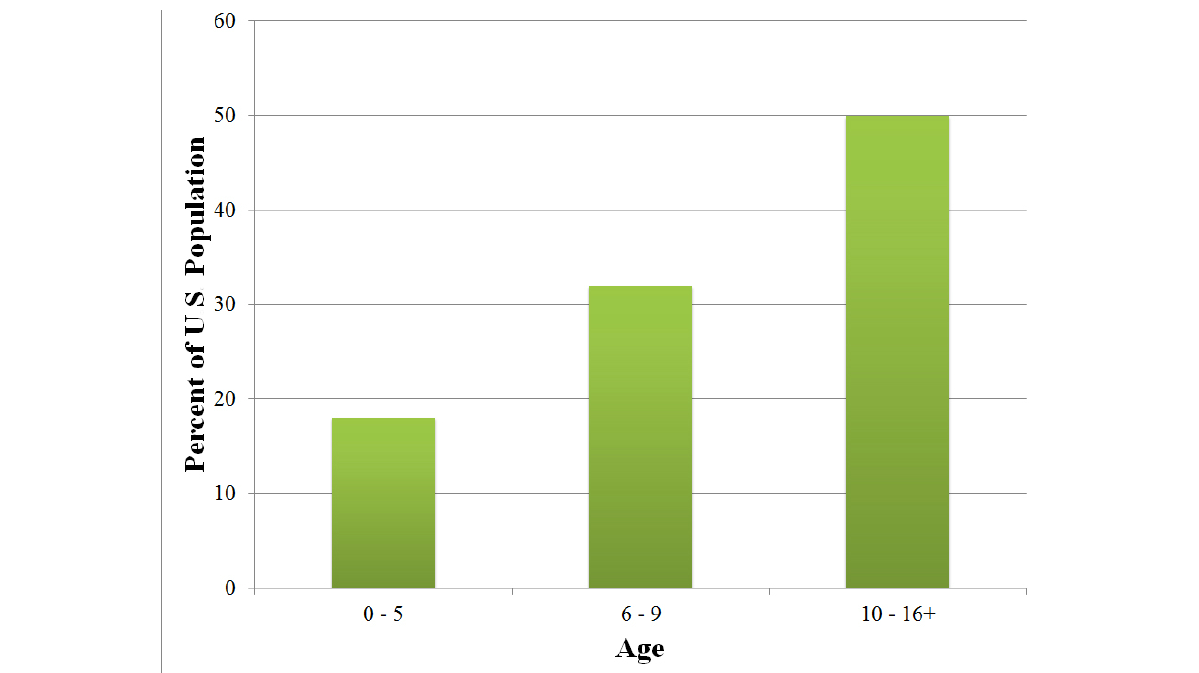
Figure 3. Reading level of US population.